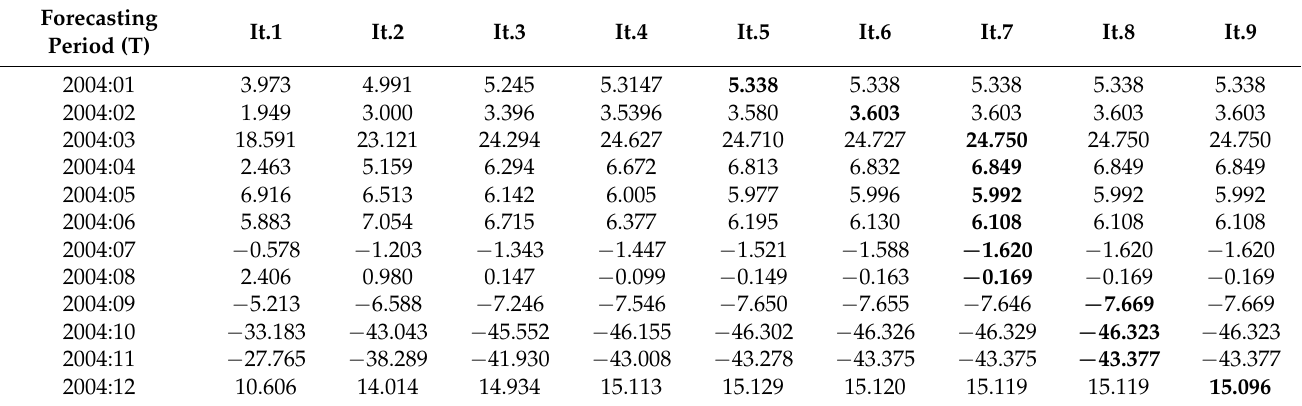
Table 7. Monthly forecasts of the company’s debt recovery efficiency (EVIND Tp ) for the year 2004, in nine subsequent iterations.